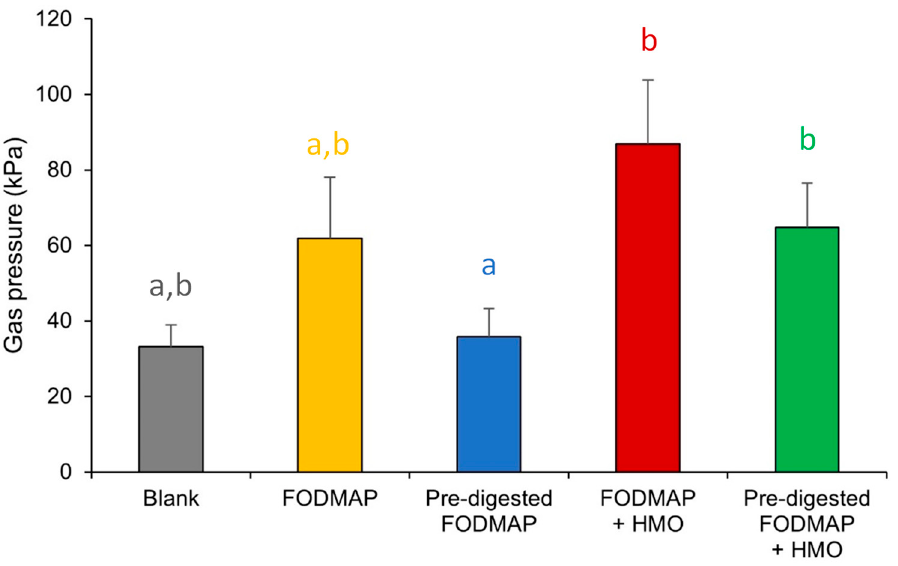
Figure 2. Changes in total gas pressure in short-term colonic batch experiments (48 h). Average ± SEM is shown across donors. Different letters represent statistically significant differences between the different test conditions ( p < 0.05). The test substrates were as follows: FODMAP (0.86 g/L FOS + 0.21 g/L stachyose + 0.21 g/L raffinose + 1.71 g/L lactose), pre-digested FODMAP (0.05 g/L stachyose + 0.10 g/L raffinose + 0.11 g/L lactose), FODMAP + HMO (FODMAP composition + 2.4 g/L 2 ′ FL/DFL + 0.6 g/L lacto-N-neotetraose), pre-digested FODMAP + HMO (pre-digested FODMAP composition + 2.4 g/L 2 ′ FL/DFL + 0.6 g/L lacto-N-neotetraose). 2 ′ FL = 2 ′ fucosyllactose; DFL = difucosyllactose; FODMAP = fermentable oligosaccharides, disaccharides, monosaccharides, and polyols; HMO = human milk oligosaccharide.